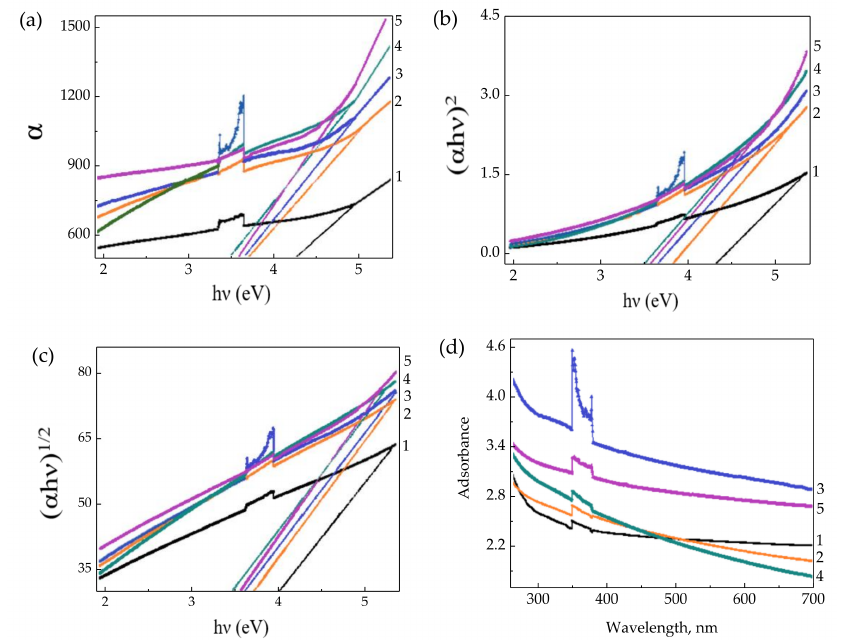
Figure 13. ( a ) h ν vs α plots, ( b ) h ν vs ( α h ν ) 2 ( × 10 7 ) plots and ( c ) h ν vs ( α h ν ) 1/2 plots and ( d ) UV–Vis spectra of polymer electrolyte films for different wt % ratios of pure PVP and polymer electrolytes: (1) pure PVP, (2) (95:5), (3) (90:10), (4) (85:15), (5) (80:20), Reproduced with permission from